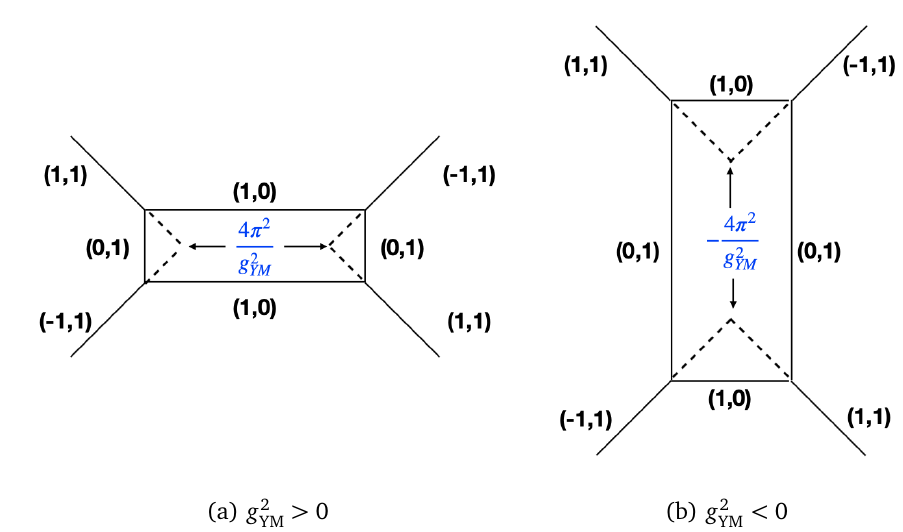
Figure 1: ( p , q ) web for N = 1 SU ( 2 ) gauge theory at positive and negative coupling. D5 branes are ( 1,0 ) branes and NS5 branes are ( 0,1 ) . The coupling is determined by the positions of the fixed ( ± 1,1 ) external